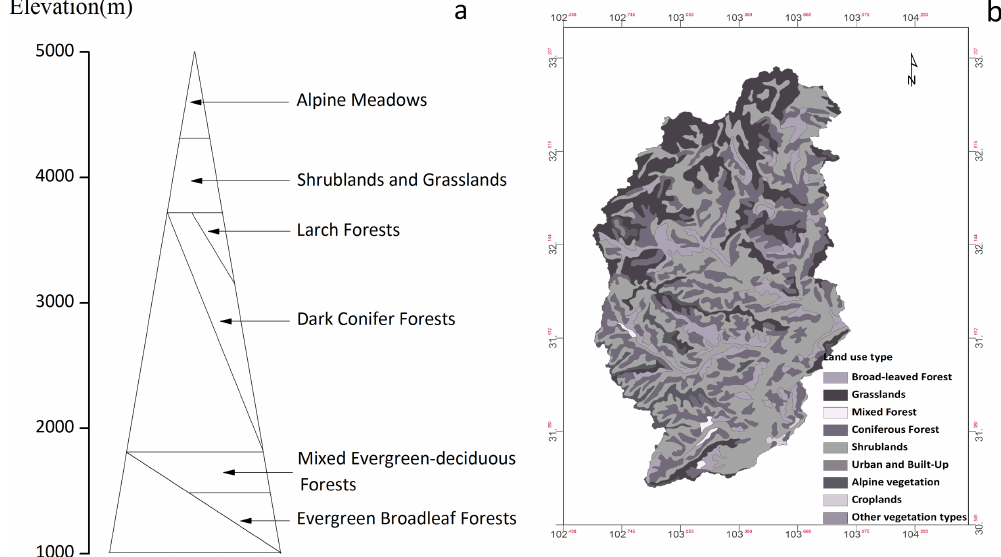
Fig. 2. Vertical distribution pattern of vegetation (a) , and land use and land cover distribution (b) in the Minjiang River